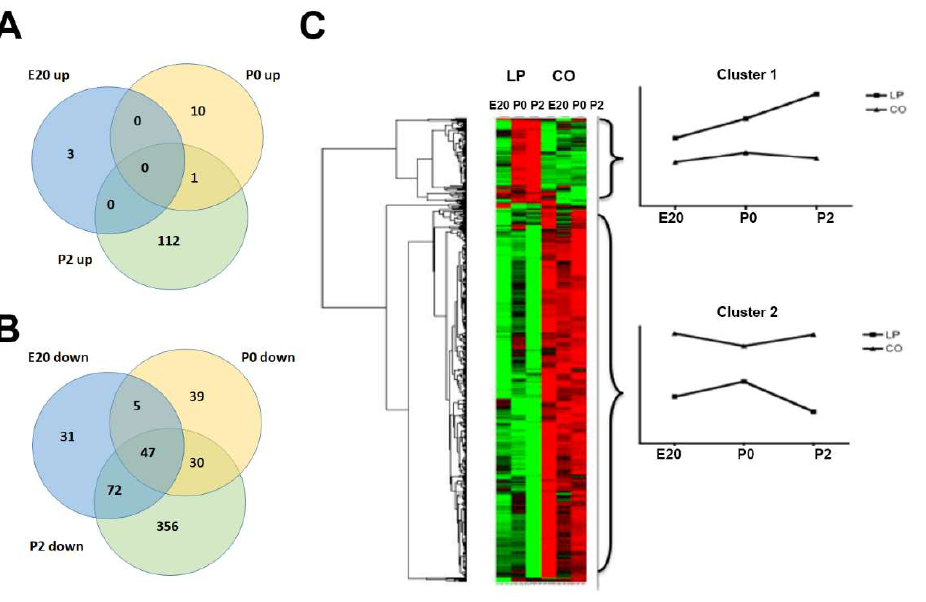
Figure 6. Cluster analysis of genes regulated by gestational low-protein diet. ( A , B ) Venn diagrams based on lists of upregulated ( A ) and downregulated ( B ) genes in the perinatal pancreas (E20, P0, and P2) programmed by the low-protein diet during gestation. ( C ) Heat map and cluster analyses of low-protein diet-regulated genes in the perinatal period. LP: Low-protein; CO: control. Green: Upregulated and Red: Down regulated